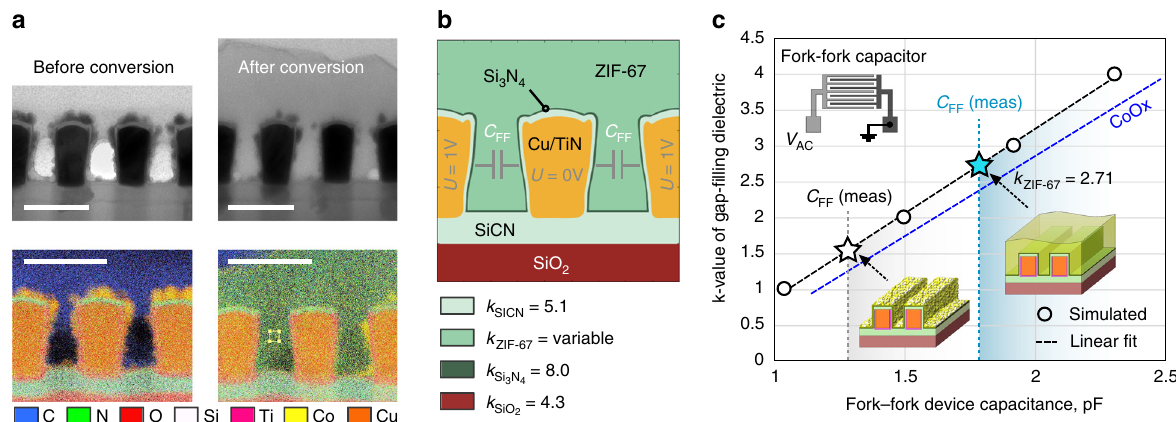
Fig. 4 Imaging and electrical evaluation of 45 nm half-pitch fork – fork capacitors with oxidized CVD Co layer before and after the conversion reaction. a TEM images and EDS elemental maps recorded on lamella cut out from the capacitor device, scalebar is 100 nm. b A 2D model of the device cross- section employed for fi nite-element capacitance ( C FF ) simulation. c k -value determination of the gap- fi lling ZIF-67 phase. The black curve